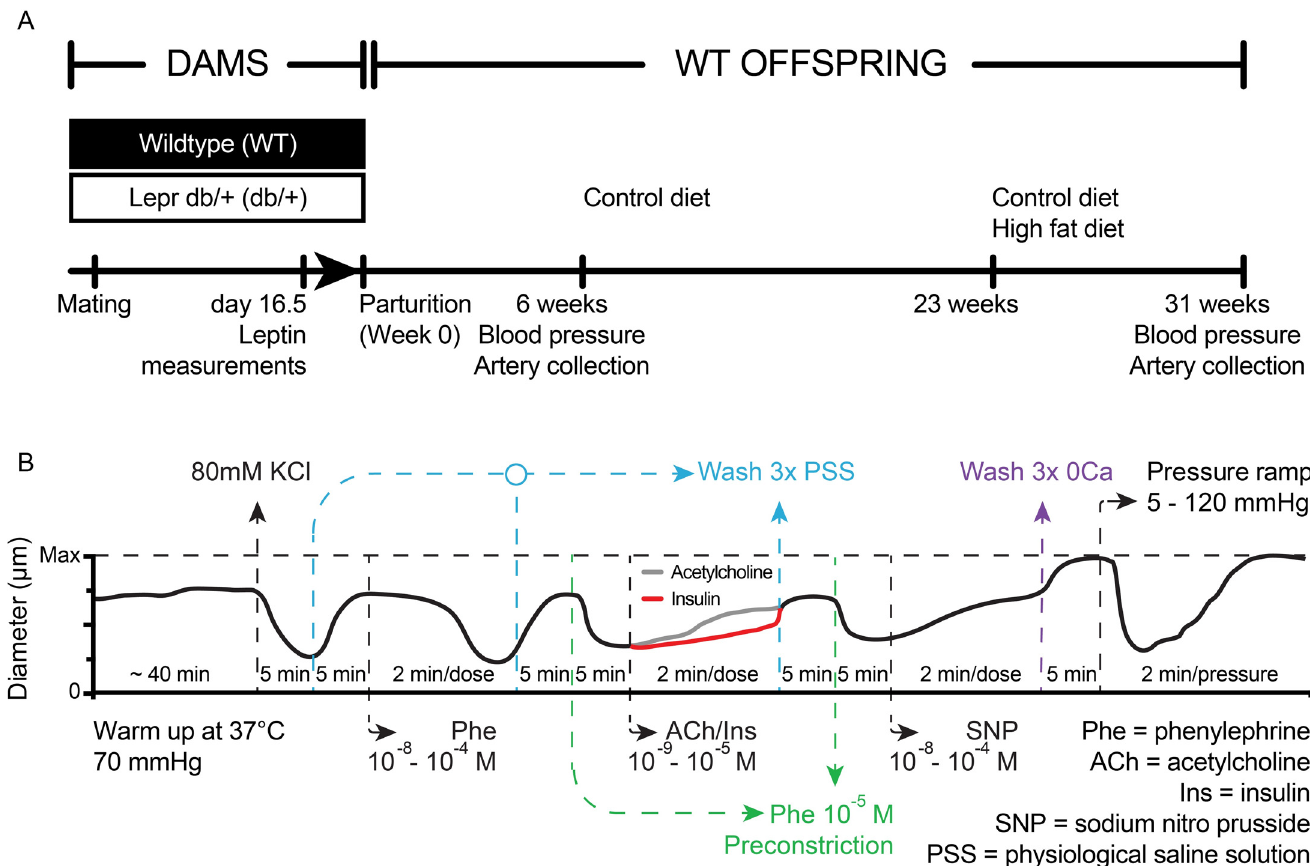
Fig 1. Experimental Design. (A) Animal experiments. Blood pressure (BP) and mesenteric artery structure and function were examined in male wild type (WT) offspring of WT-control and hyperleptinemic Lepr db/+ dams. (B) Protocol to test vascular reactivity in isolated, cannulated and pressurized mesenteric resistance arteries. Two arteries were tested for each mouse. The red and green lines indicate that only one of the arteries from each mouse was exposed to either insulin or acetylcholine. At the end of each experiment all arteries were incubated in calcium-free buffer to obtain maximal passive diameters and subsequently exposed to varying levels of intraluminal